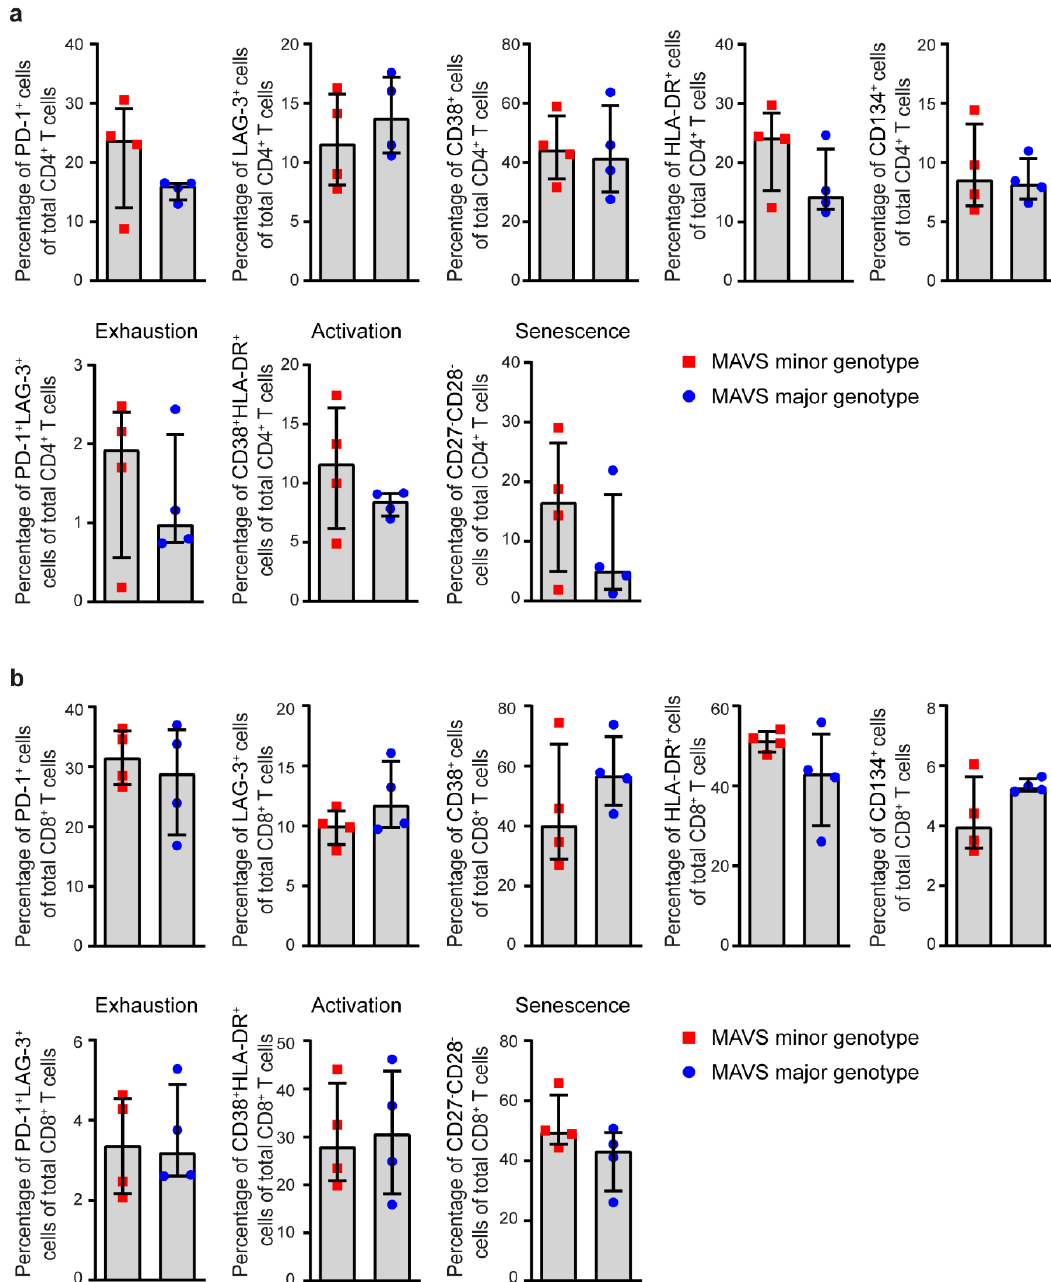
Figure 3. MAVS genetic variation does not a ff ect T cell exhaustion, activation, and senescence. ( a ) Percentages of PD-1 + , LAG-3 + , CD38 + , HLA-DR + , CD134 + , exhausted (PD-1 + LAG-3 + ), activated (CD38 + HLA-DR + ), and senescent (CD27 − CD28 − ) cells within CD4 + and ( b ) CD8 + T cells of untreated HIV-1-infected individuals with a MAVS minor or MAVS major genotype 2.5–3.5 years p.SC were analyzed using flow cytometry. Each square or dot represents a different study participant (median ± IQR). No significant differences between HIV-1-infected individuals with a MAVS minor or MAVS major genotype were observed.